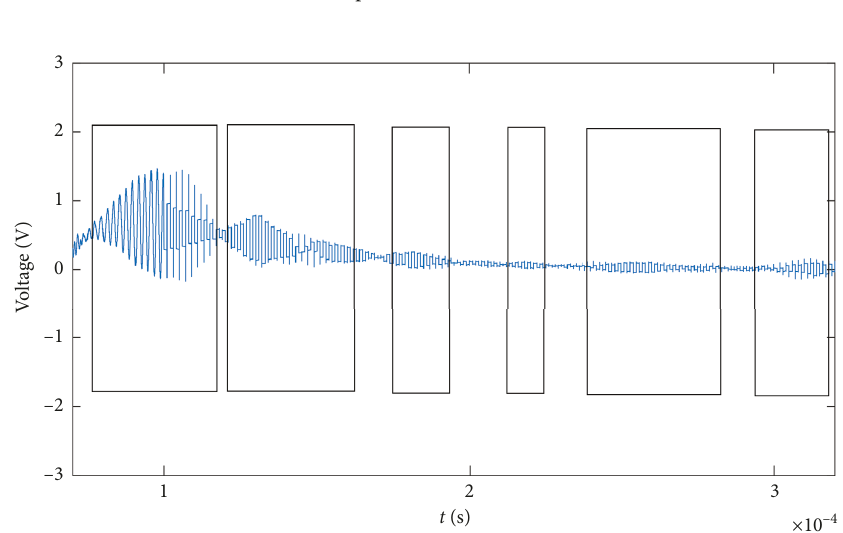
Figure 11: Effective signal denoising